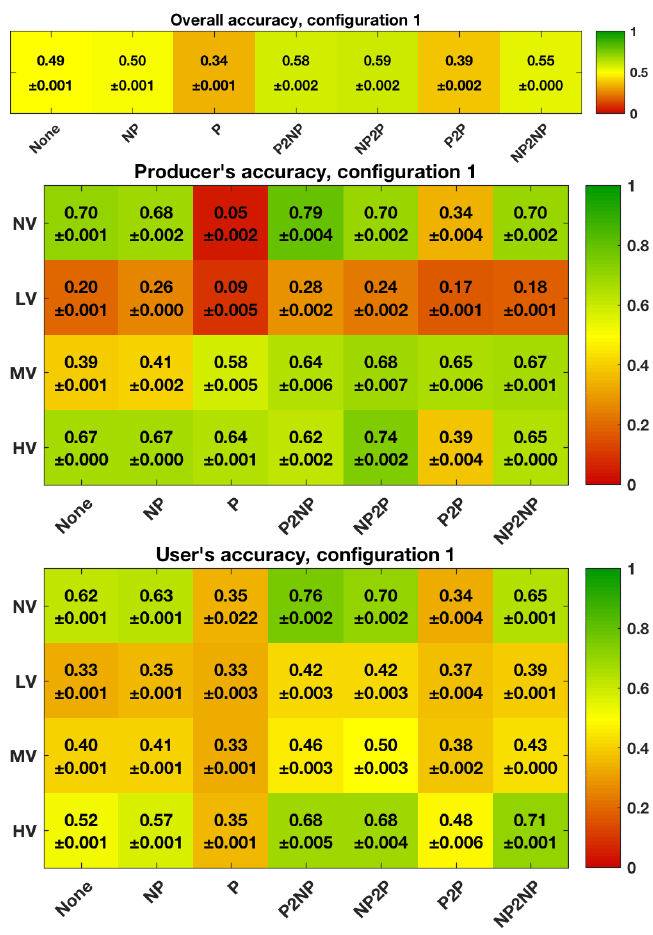
Figure 6. The averages and standard deviations of the overall (top), producer’s (middle) and user’s (bottom) accuracies for Configuration